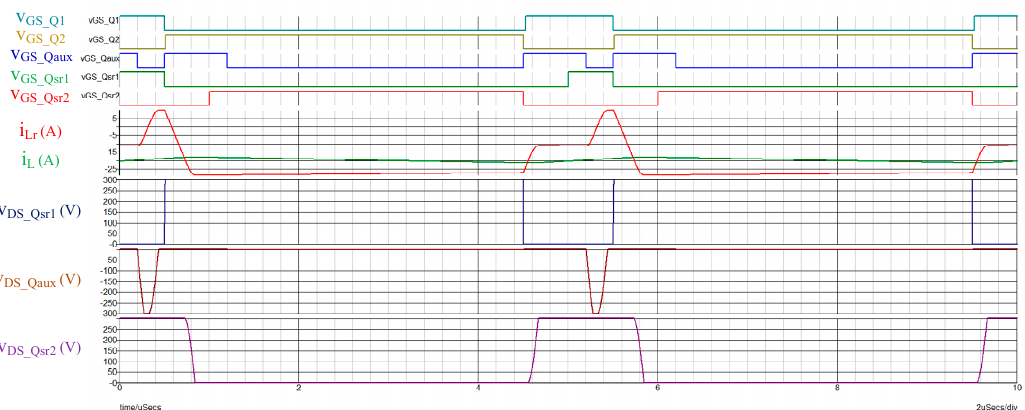
Figure 15. Simulation results: v GS and v DS waveforms of each switch, resonant inductor and output inductor current waveform at V O = 50 V, Io = − 20 A.